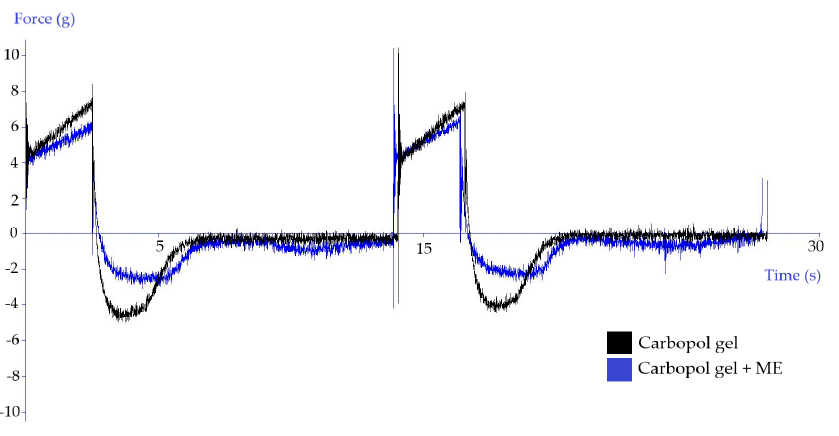
Figure 4. The influence of the reference microemulsion (ME) on the texture of Carbopol gel.